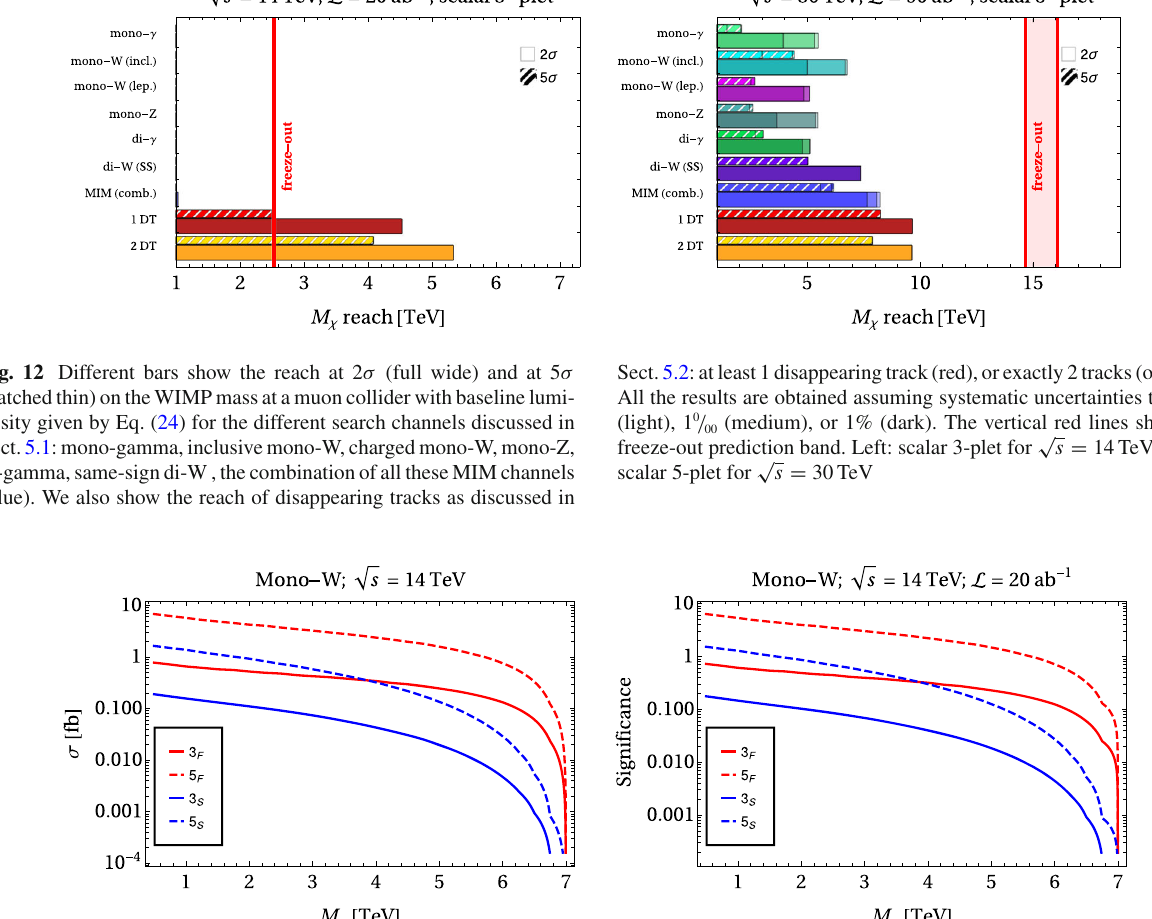
√ s = 14TeV. In both plots, the